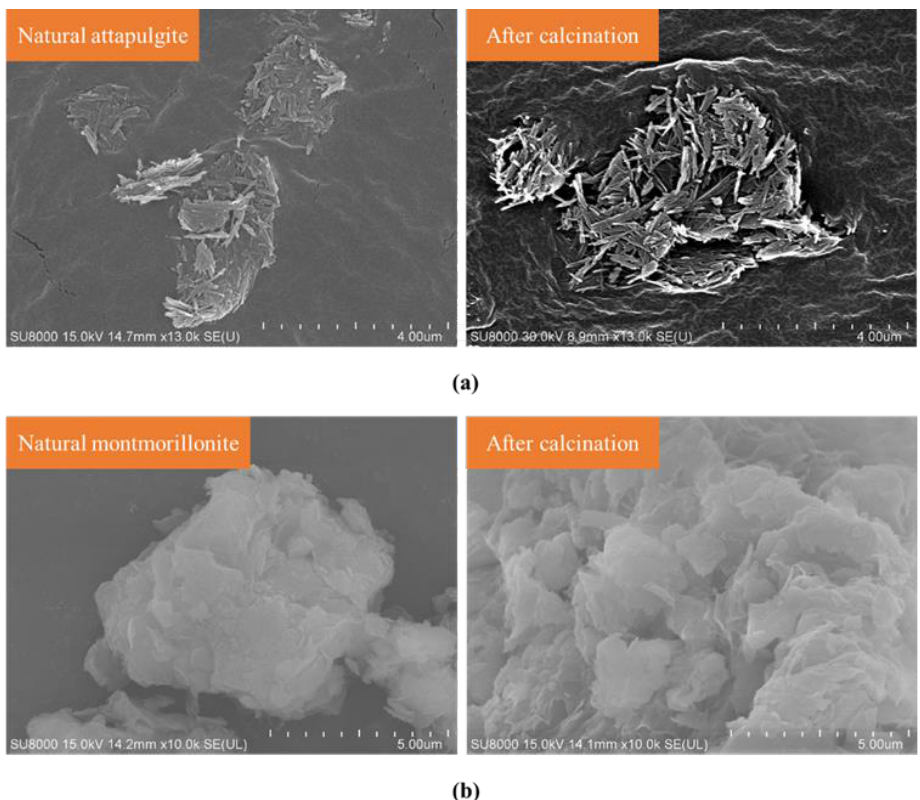
Figure 4. Microtopography: ( a ) attapulgite; ( b ) montmorillonite.